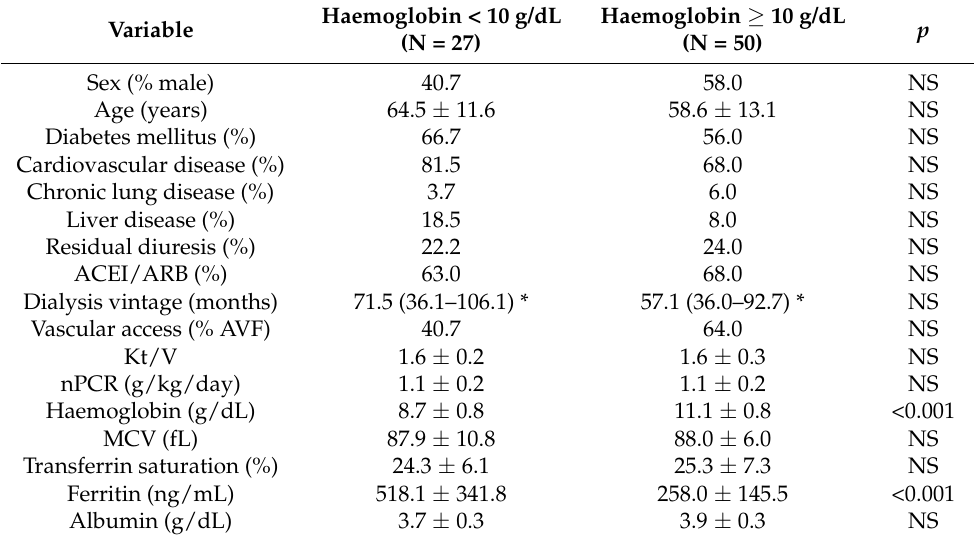
Table 2. Comparison of study